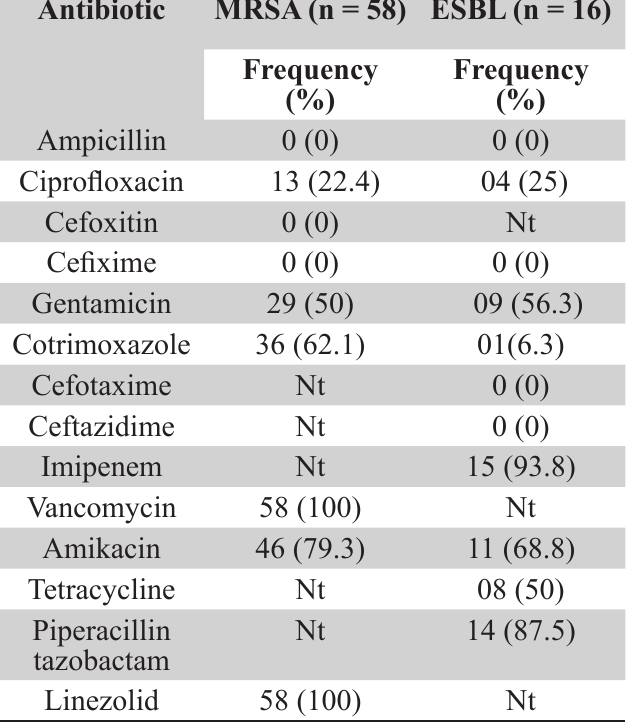
Table 4. Antibiotic sensitivity pattern of MRSA and ESBL producers.